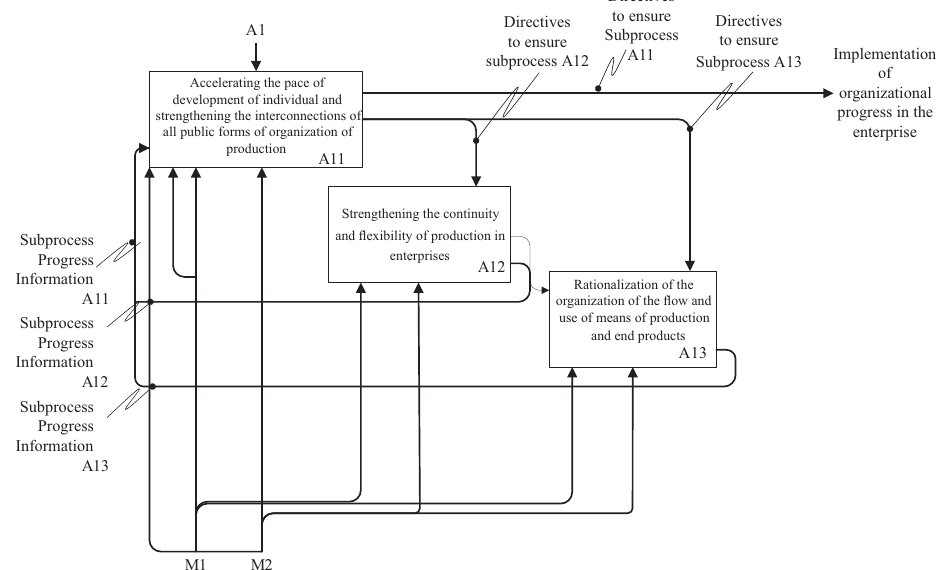
Figure 4. The decomposition of the functional model for achieving the process